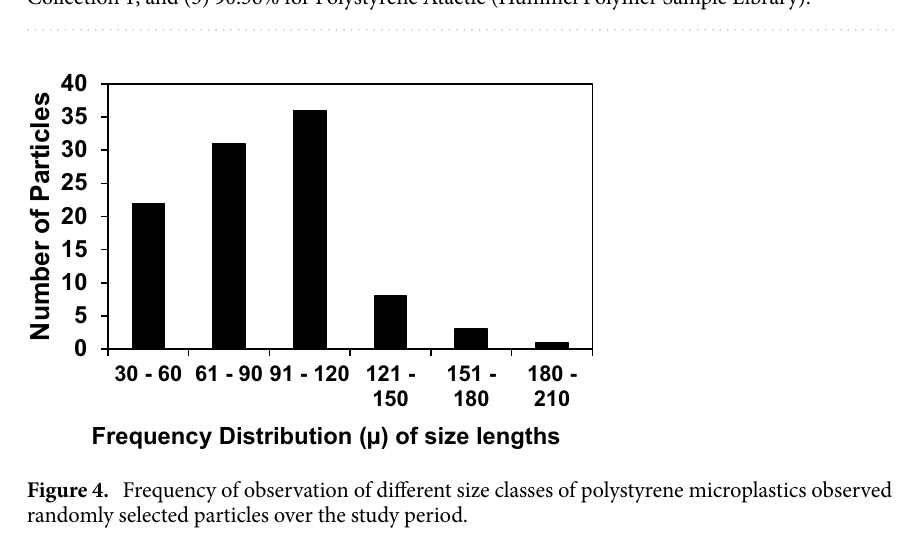
Figure 3. Baseline-corrected FT-IR spectrum of microplastic particle in water samples (top panel) particle and comparison reference spectra for standard forms of polystyrenes (the most common commercial forms). The percentage match for the three reference forms were: (1) 95.15% for Polystyrene Standard, typical MW 200.000 (HR Aldrich FT-IR Collection 1, (2) 91.40% for Polystyrene Standard, typical MW 50.000 (HR Aldrich FT-IR